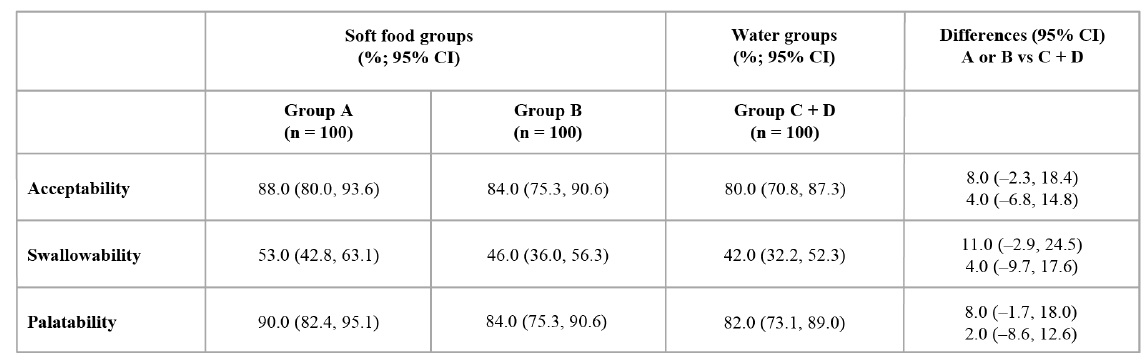
Figure 3. Acceptability, swallowability, and palatability of 3 mm placebo mini-tablets by treatment group. Bars represent 95% CIs. Group A: 16 mini-tablets with soft food. Group B: 32 mini-tablets with soft food. Group C + D: 16 mini-tablets with water and 32 mini-tablets with water, which were pooled for statistical comparisons. Acceptability was defined as swallowing all of the mini-tablets with no chewing or swallowing ≥ 80% of the mini-tablets with or without chewing. Swallowability was defined as swallowing all of the mini-tablets without chewing, with no residuals of the mini-tablets found in an oral inspection. For the assessment of palatability, the immediate reactions of the child after the administration of the mini-tablets were recorded as positive (pleasant), neutral (no change), or negative (unpleasant) according to the pre-defined criteria. A positive or neutral reaction qualified as palatable. CI, confidence interval; n, number of evaluable subjects.